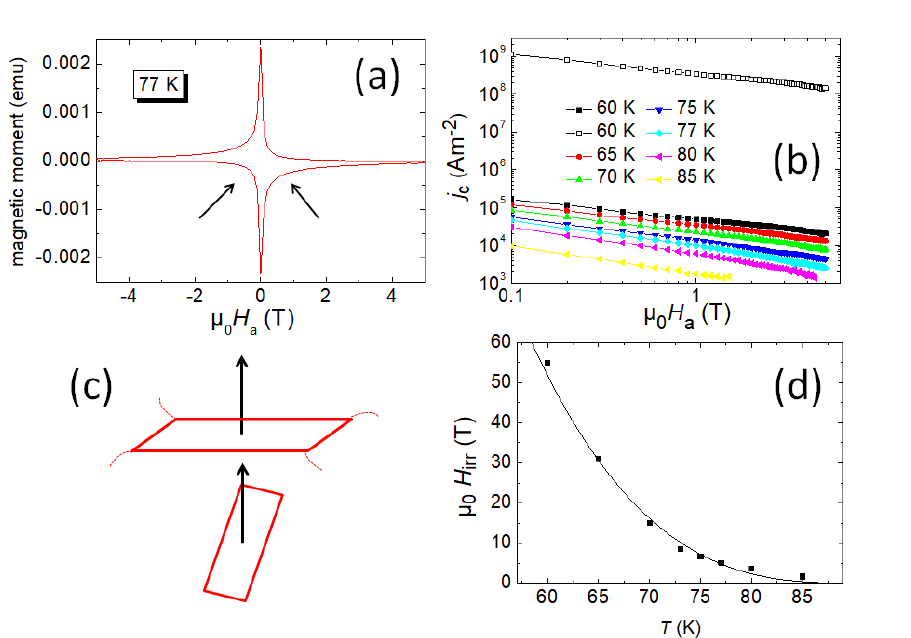
Figure 5. ( a ) Magnetization loop at 77 K, measured on a single foam-strut piece. Arrows point to the asymmetry of the loop. ( b ) j c = intergranular current density, for various temperatures (full symbols). Open symbols show an intragranular current density at 60 K (determined as per the text). ( c ) Schematic sketch of foam-strut orientation to the magnetic field. (Upper) situation in the magnetization measurement, (lower) situation in the real foam sample. ( d ) Irreversibility field, H irr as function of temperature. Solid line is a fit using relation H irr ( T ) = H 0 ( 1 − T / T c ) n with n =